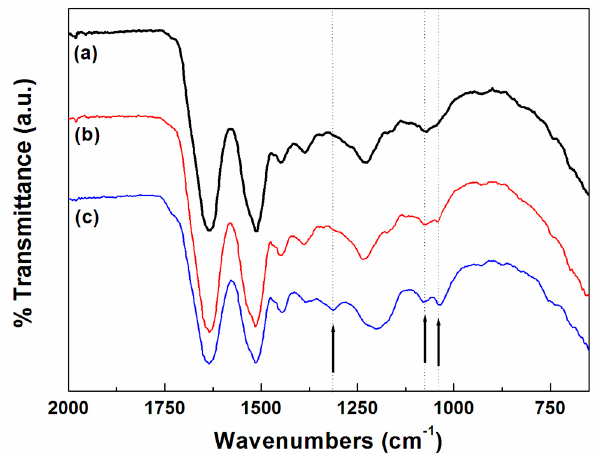
Figure 3. FT–IR-ATR spectra of wool fabrics dyed with spent coffee extract at 90 ° C for 60 min: ( a )